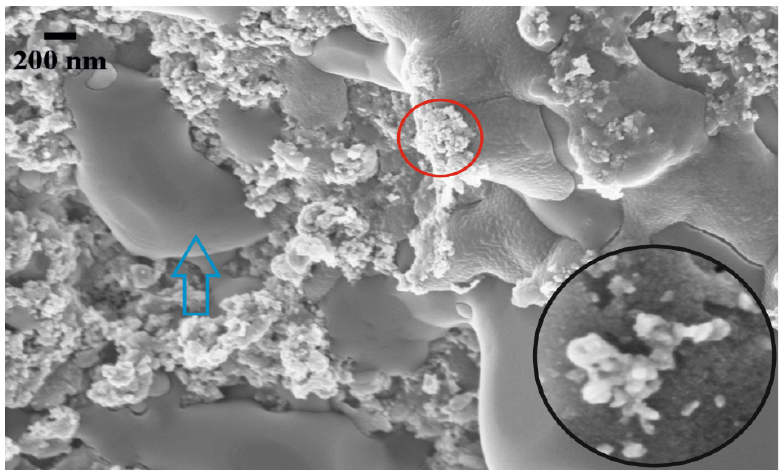
Figure 6. Scanning electron microscopy (SEM) image of 1.0 wt % Copper Oxide (×75,000 magnification). The blue arrow points at the surface of molten salt free from nanoparticles whilst the red circle shows agglomerate of CuO. Bottom right side shows a magnified image of copper oxide